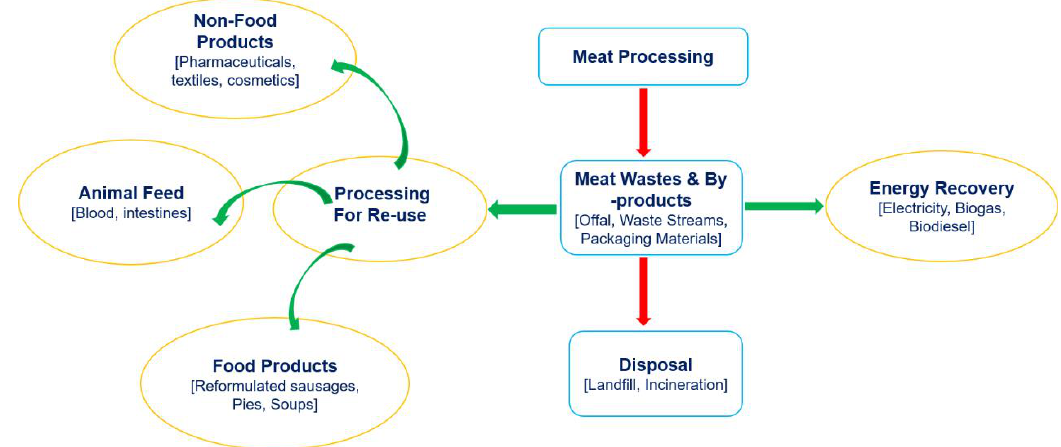
Figure 2. Meat by-products and waste reduction and reutilization strategies.